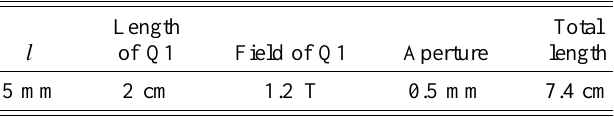
TABLE IV. Parameters of the defocusing optics for laser-Compton cooling for JLC/NLC at E 0 (cid:1) 2 GeV and C (cid:1) 10